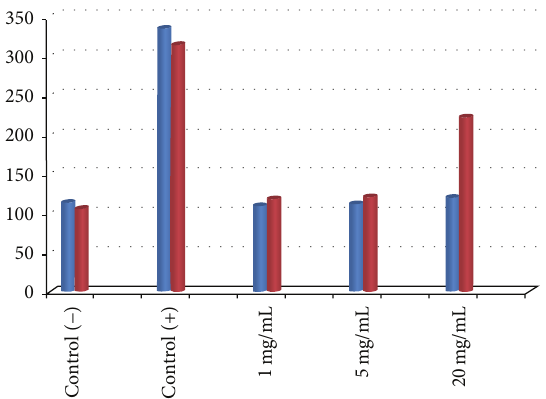
Figure 6: Damage index (DI) average of negative and positive controls and hot aqueous extract of Acacia aroma , at different concentrations (blue) and DI of negative and positive controls and ethanolic extract of A. aroma , at different concentrations